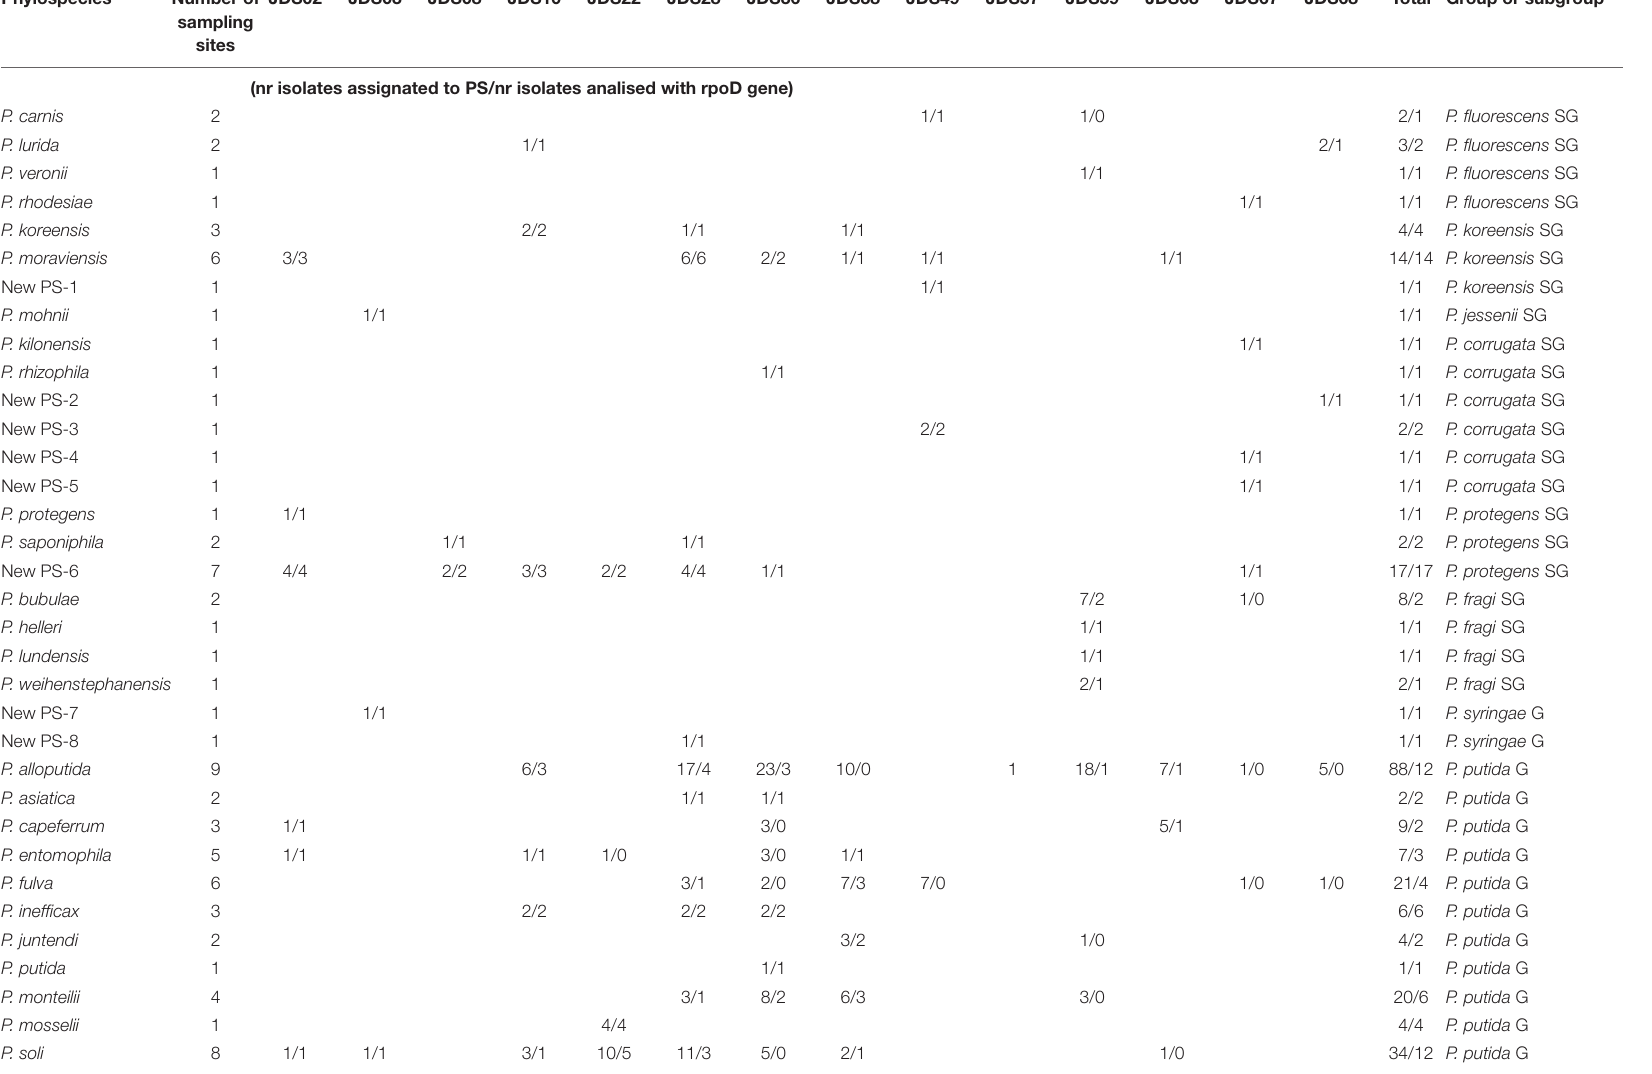
TABLE 2 | Strains assigned to species or to new phylospecies and their corresponding sampling sites of isolation. Phylospecies Number of